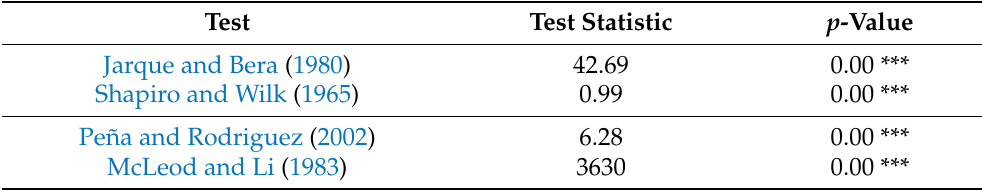
Table 1. Results of normality and non-linearity tests for the first differences of implied inflation. Test Test Statistic p -Value Jarque and Bera (1980) 42.69 0.00 *** Shapiro and Wilk (1965) 0.99 0.00 *** Peña and Rodriguez (2002) 6.28 0.00 *** McLeod and Li (1983) 3630 0.00 *** *** indicates significance at the 1%